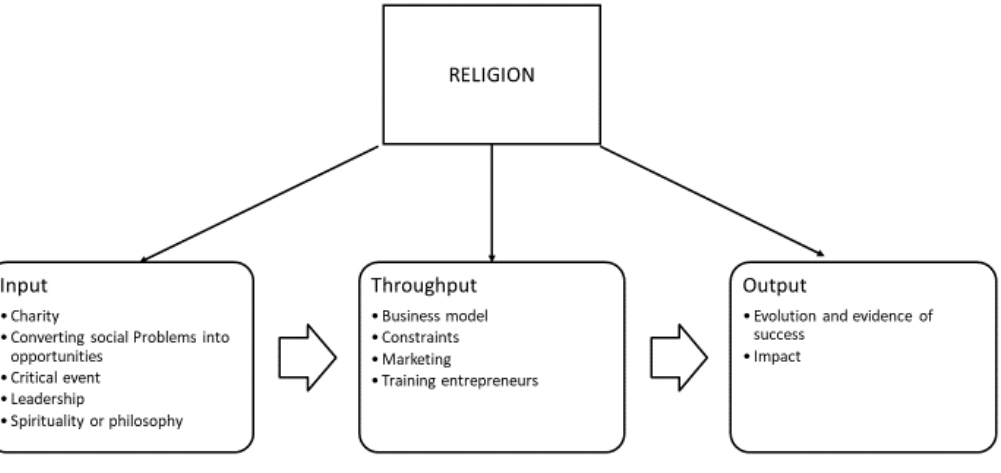
Figure 3. Thematizing the codes.